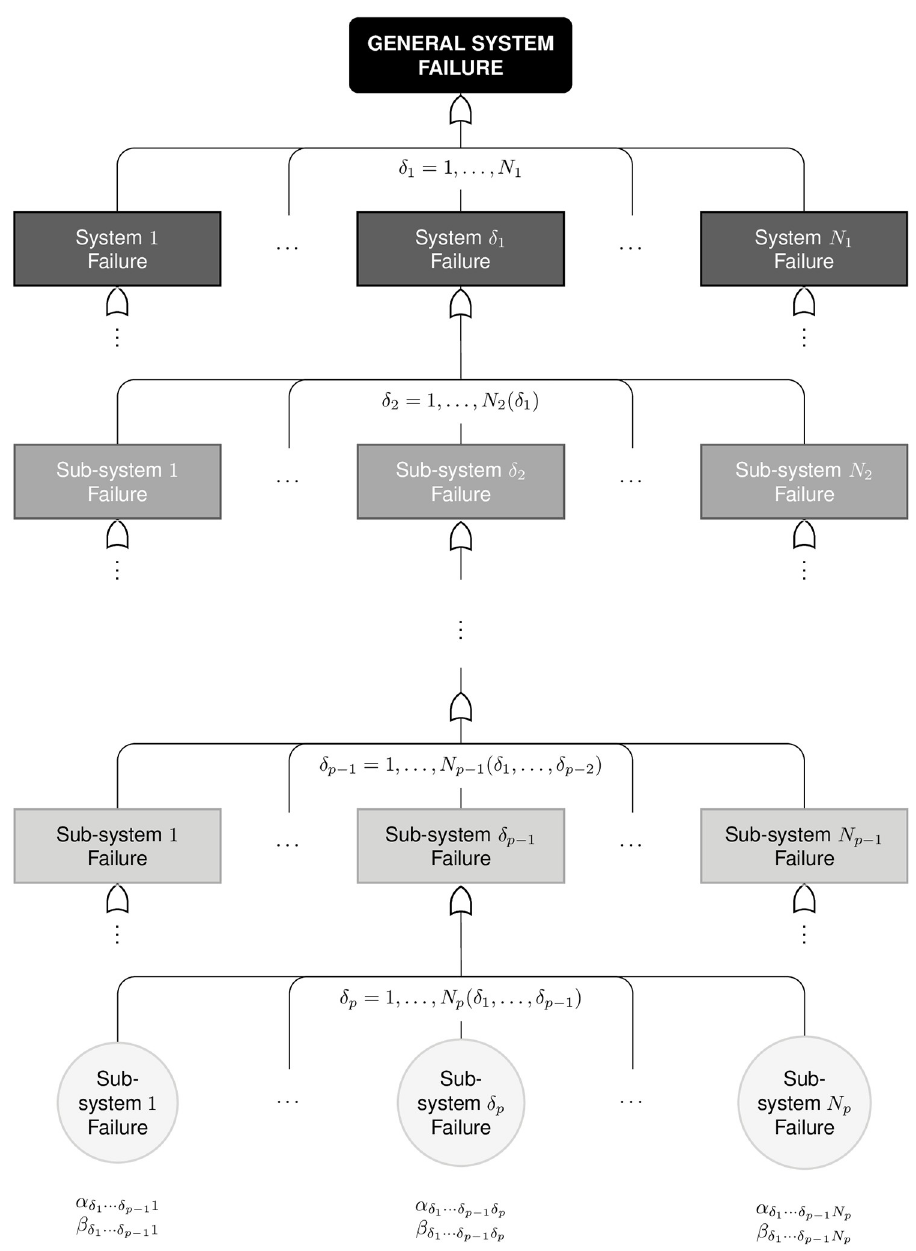
Fig 3. System composition. Fault tree analysis (FTA) of the general system with hierarchical failure modes ( p levels of nesting).